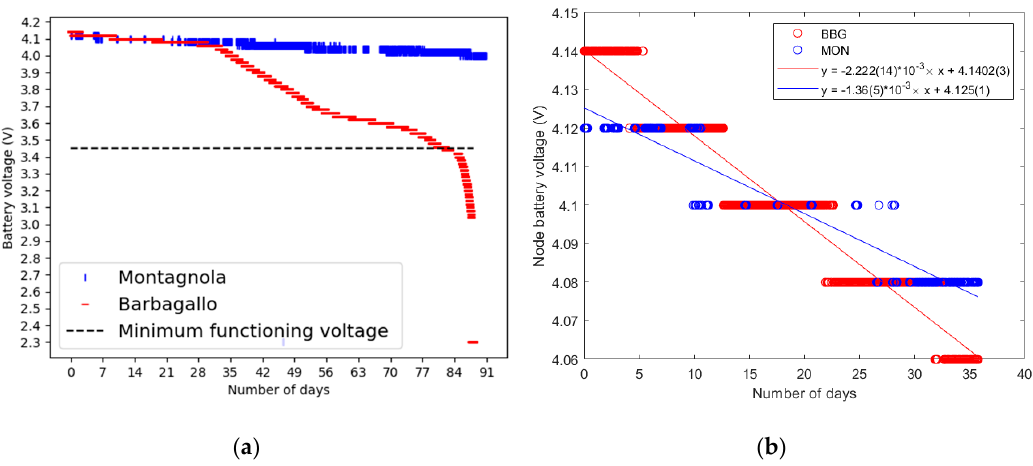
Figure 6. Variation of the battery voltages with time for nodes at Montagnola (MON) and Mt. Barbagallo (BBG) during a 3-month period ( a ) with a focus over the first 35 days at the onset of the deployment ( b ). Figure 6b also displays linear regression models together with the corresponding coefficients and their standard errors for a 95% confidence interval.